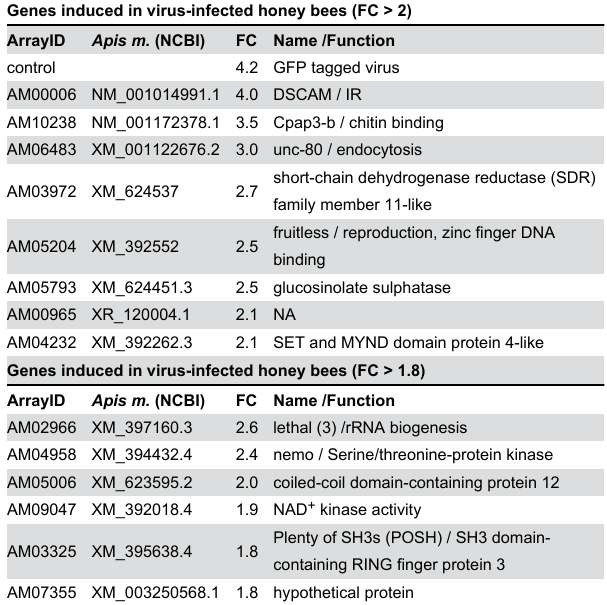
Table 2. Identification of the honey bee transcripts with the greatest increase in expression in response to virus infection or dsRNA-treatment.